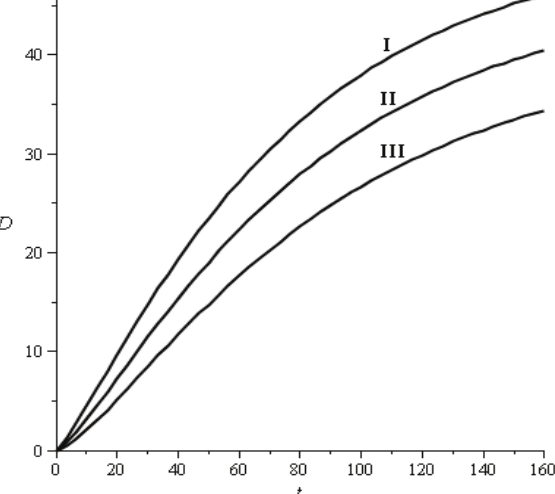
Figure 1 . Diameter growth models: Quality I, D = 51.68 (1 (cid:28)(cid:4)(cid:9) (cid:28) 0.014318· t D = 46.645633 (1 (cid:28)(cid:4)(cid:9) ) 1.337062 ; and Quality III, D = 40.644134 (1 (cid:28)(cid:4)(cid:9) (dbh, D , in cm and time t in years). The coefficient of determination was always greater than 0.999.